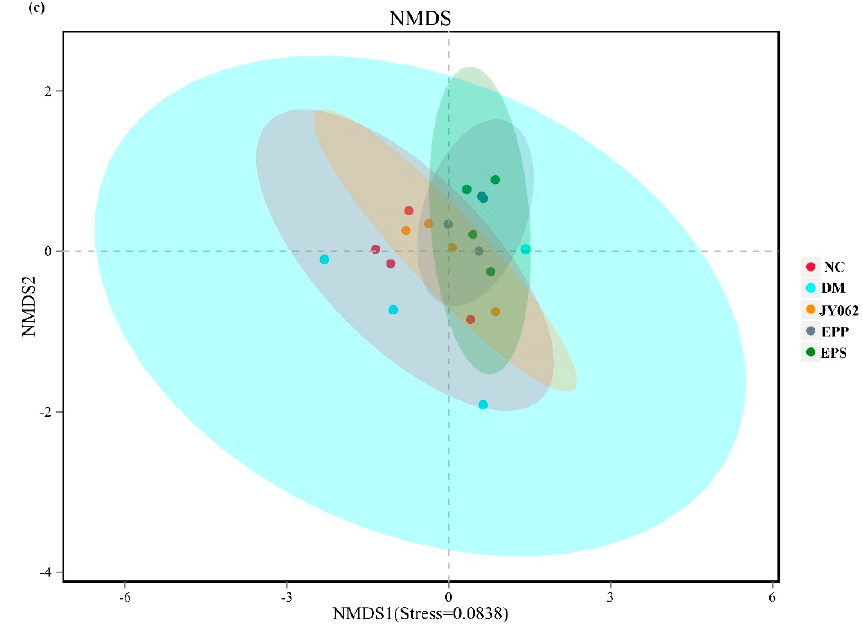
Figure 4. Differences in intestinal microbiome structure among the five groups ( n = 4). Beta diversity analysis: ( a ) principal component analysis-PCA; ( b ) principal coordinates analysis-PCoA; ( c ) non- metric multidimensional scaling-NMDS.